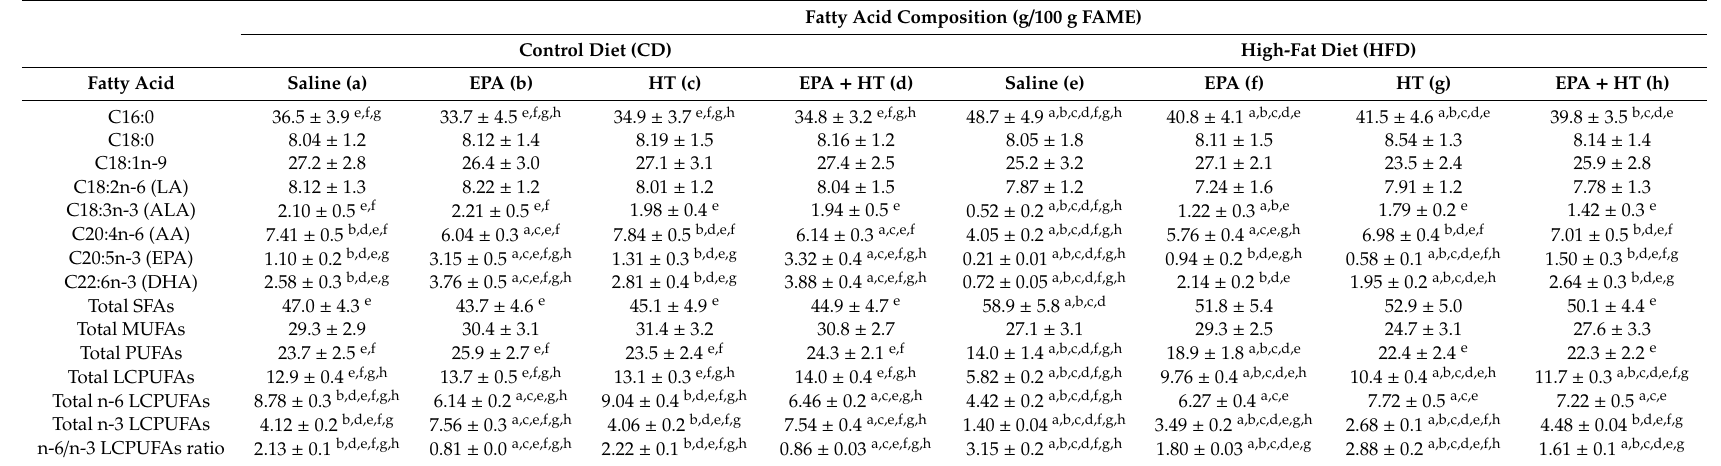
Table 3. Most relevant fatty acid composition of epididymal white adipose tissue (WAT) phospholipids obtained from control diet- (CD) and high-fat diet (HFD)-fed mice subjected to eicosapentaenoic acid (EPA), hydroxytyrosol (HT) or EPA plus HT